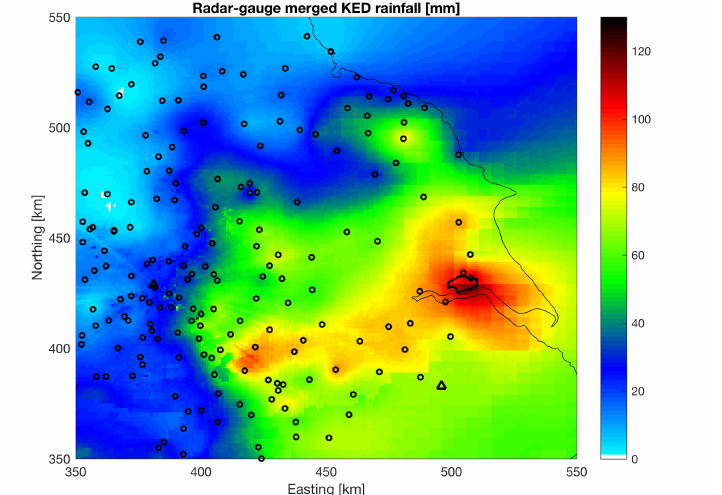
Figure 5. Accumulated rainfall obtained from Kriging with External Drift on 25 June 2007. The circles represent the rain gauges used. The triangles are the weather radars. The study site is represented by a black polygon. Please note that during this event, only the Hameldon Hill radar (located in the west of the image) was